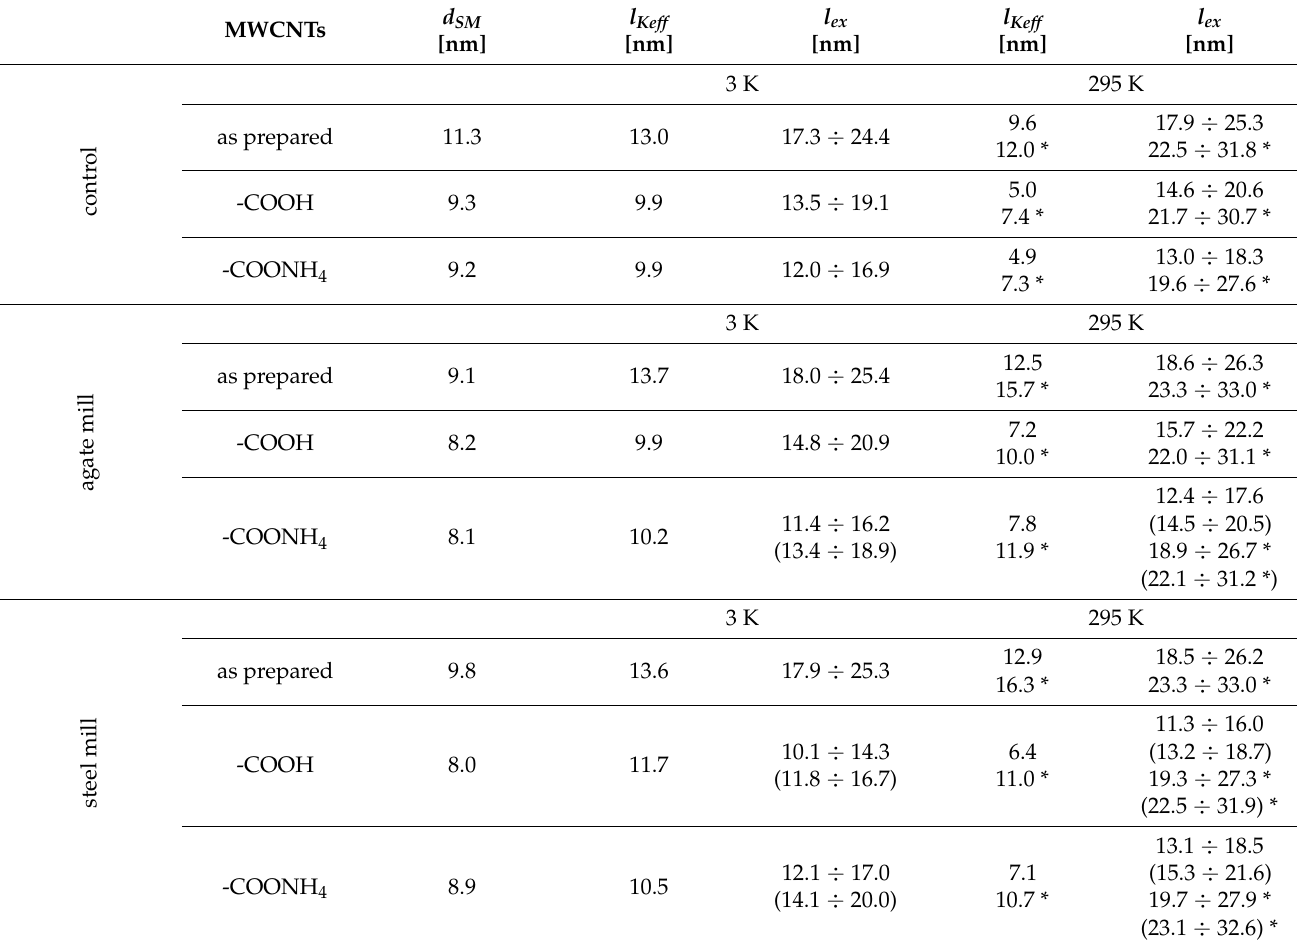
Table 3. Diameters ( d SM ) of Fe (C,O) -NPs embedded in as prepared MWCNTs, MWCNTs-COOH, and MWCNTs-COONH 4 unground and ground in the agate and steel mill determined on the basis of hyperfine fields obtained in Mössbauer experiments and the effective anisotropy constant. Magnetostatic exchange lengths ( l ex ) and anisotropy lengths ( l Keff ) were calculated from A parameters estimated for NPs. See the text for details and description below the